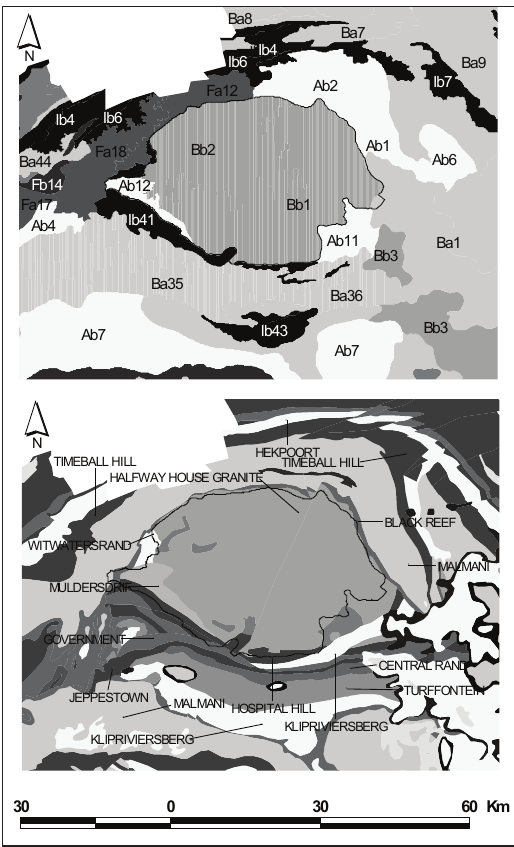
Fig. 3. Land Types (above) and Geology (bottom) within the Egoli Granite Grassland